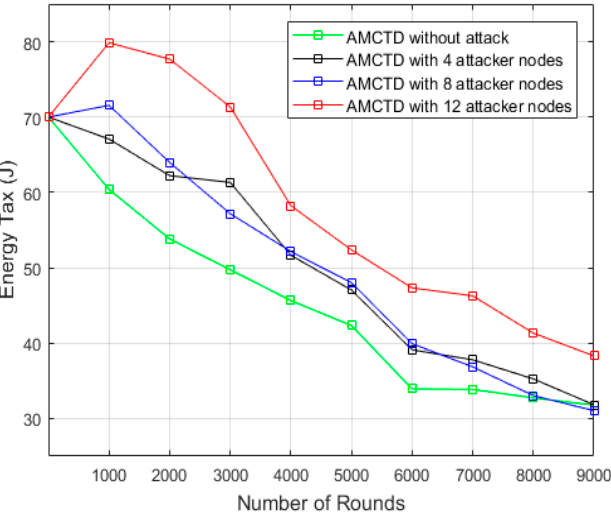
Figure 10. AMCTD: Energy Tax without attack and with 4, 8 and 12 Attacker Nodes.